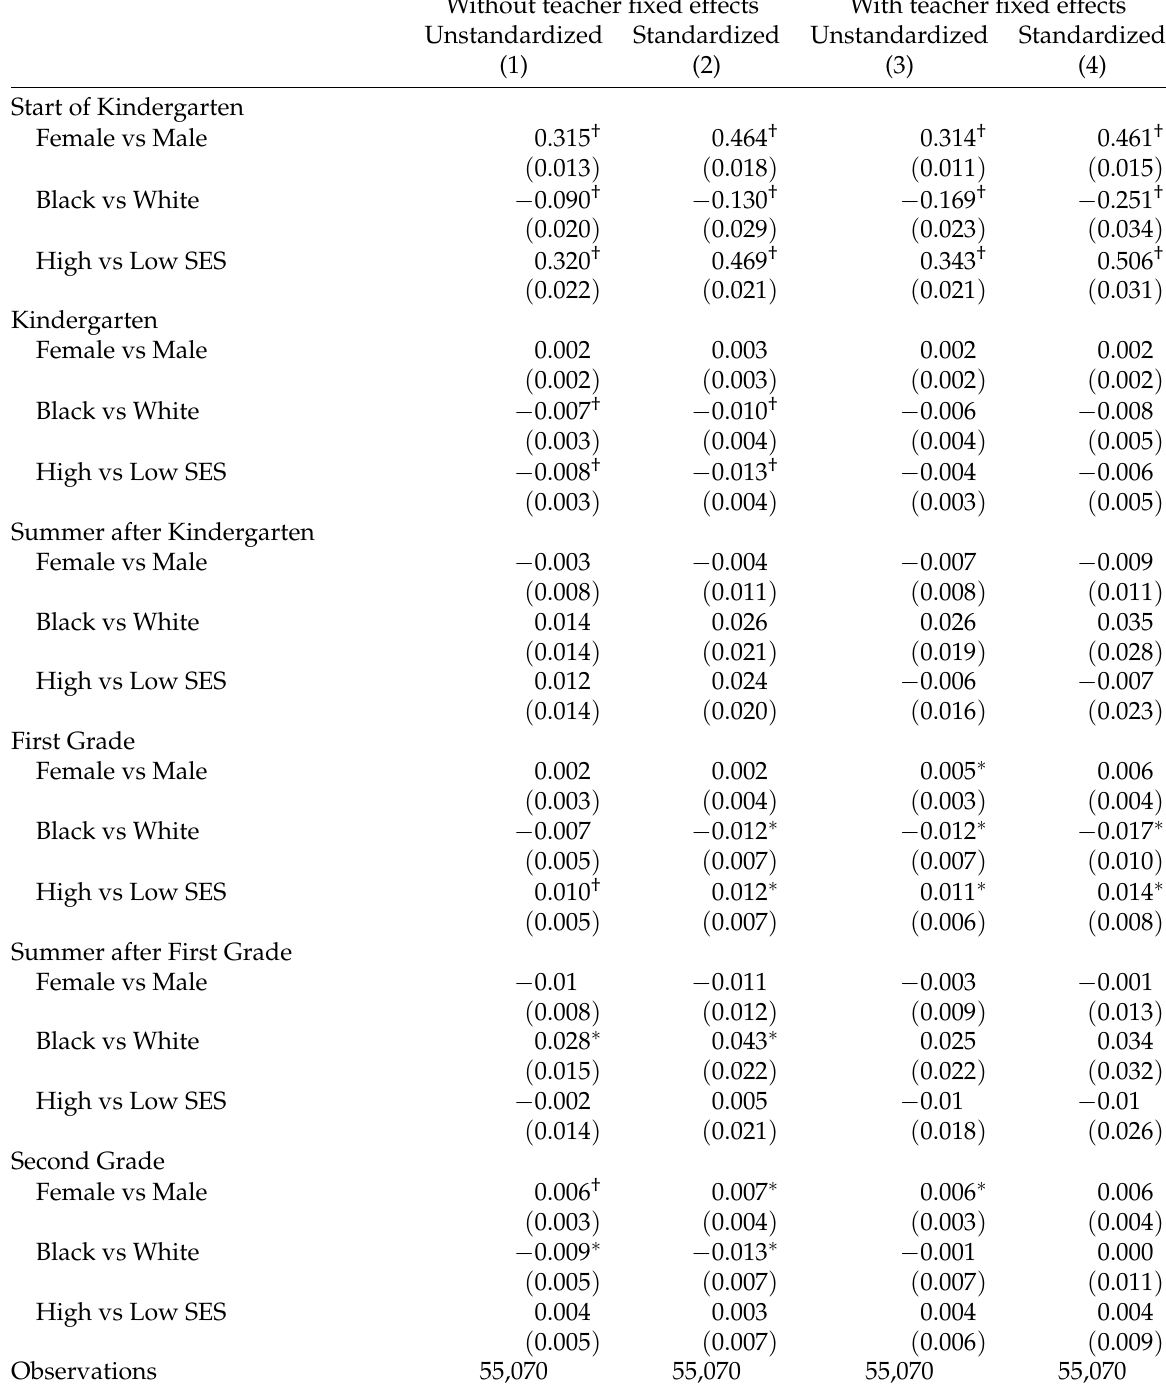
Table 2: Estimates from hierarchical linear models predicting gaps in approaches to learning at kindergarten entry and growth in gaps during school and nonschool periods (ECLS-K